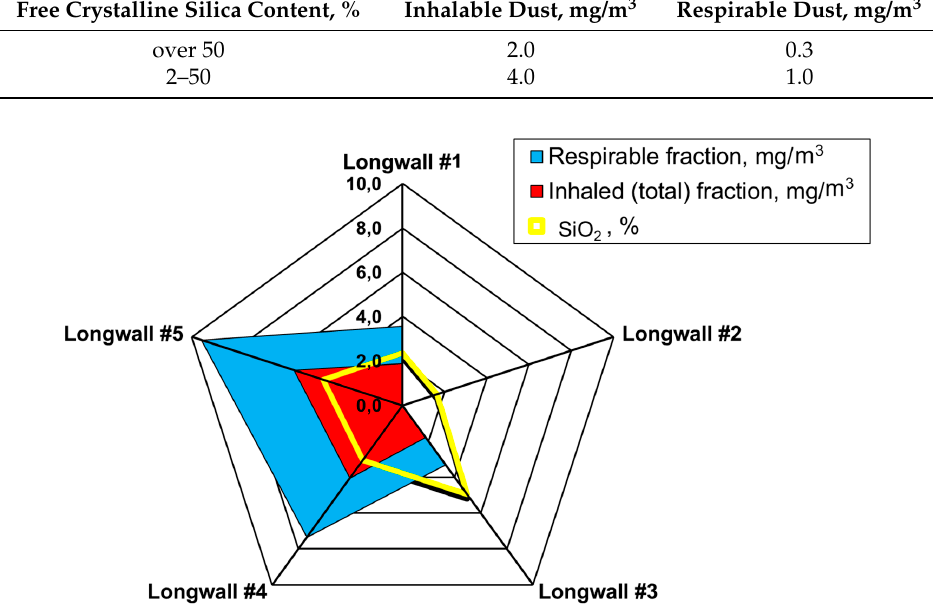
Table 3. Limit values for dust containing free crystalline silica in compliance with Polish regulations [34]. Free Crystalline Silica Content, %